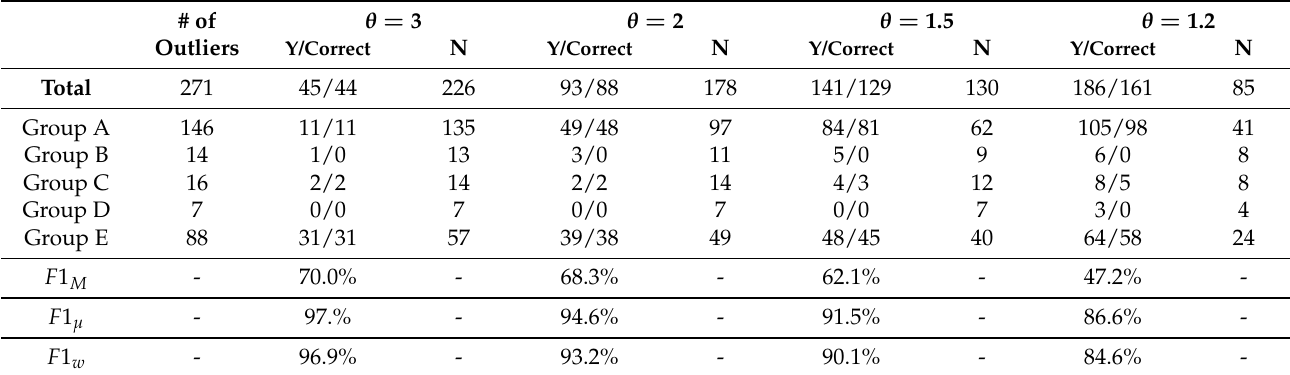
Table 2. Effectiveness of intra-class